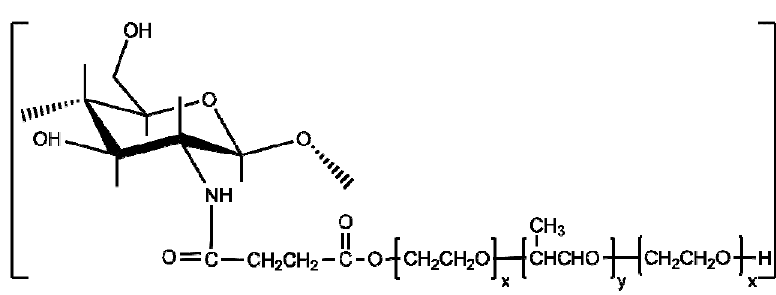
Figure 8. Chemical structure of chitosan- g -Pluronic.